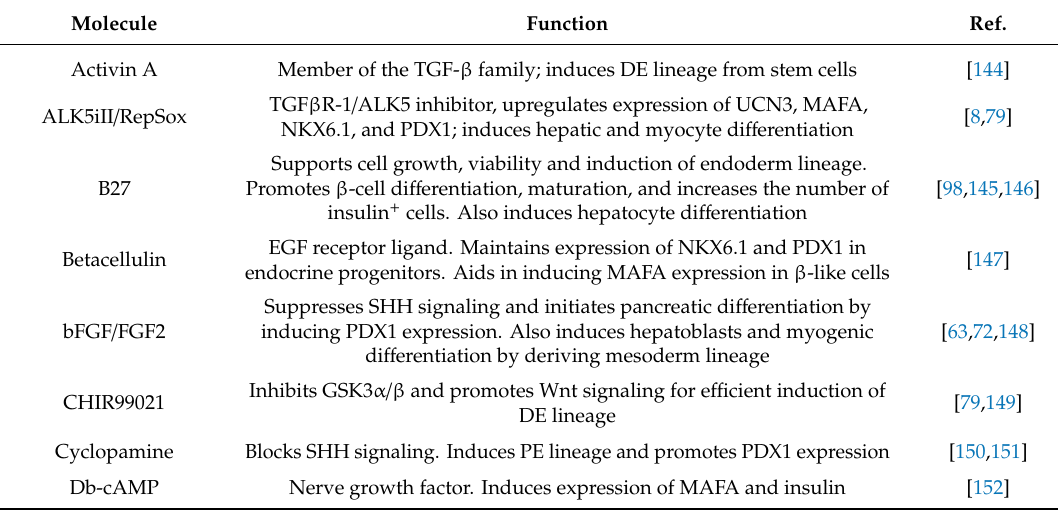
Table 2. Small molecules used for di ff erentiation of insulin / glucose-responsive cells from iPSCs. Molecule Function